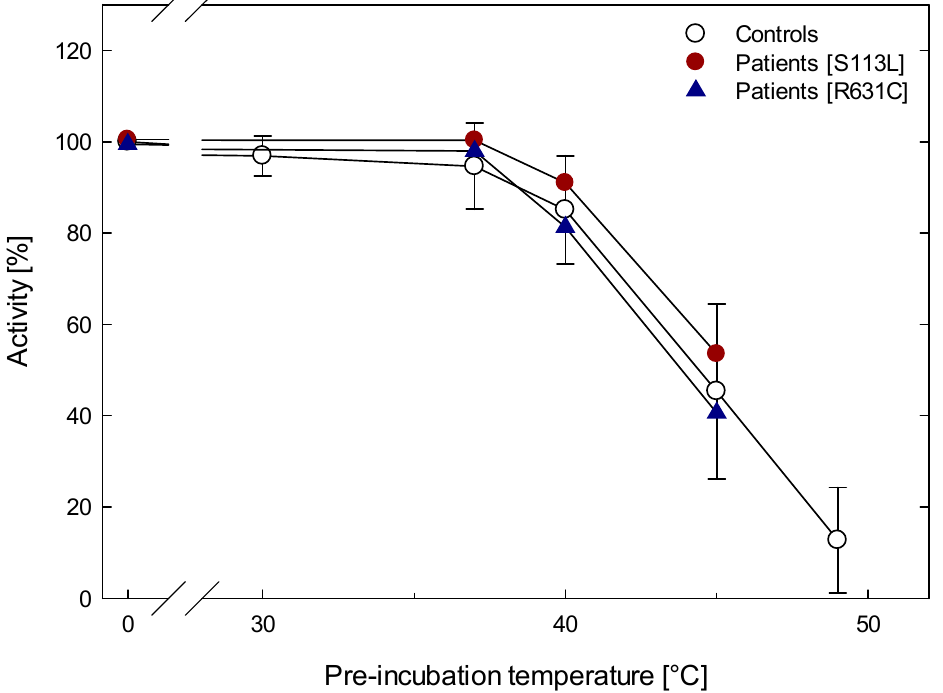
Figure 1. CPT activity in muscle homogenates of wild-type (n = 7) and mutant (n = 5) [p.Ser113Leu (n = 3) and p.Arg631Cys (n = 2)] with pre-incubating at increasing temperatures for 6 min. The error bars correspond only to data of wild-type.